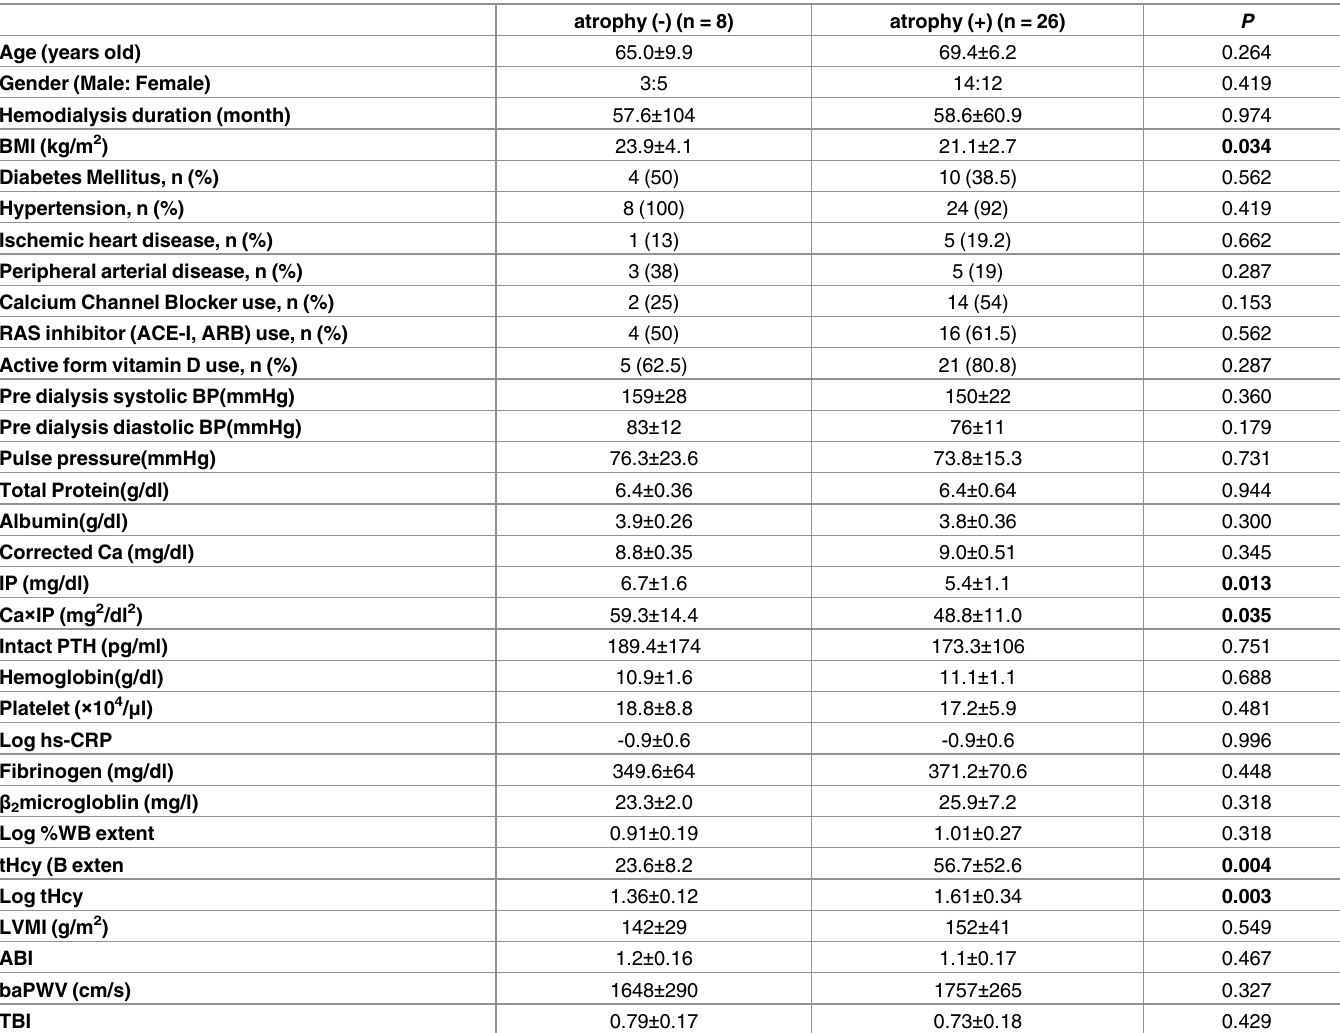
Table 4. Comparison with or without hippocampal